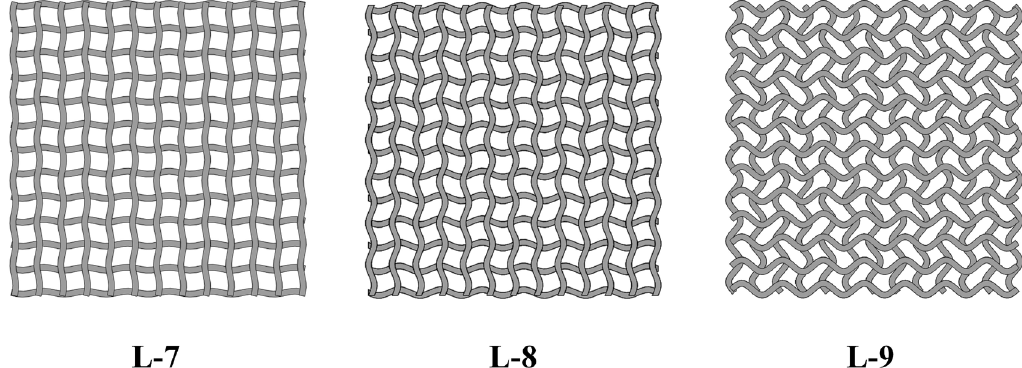
Figure 8. Plane diagrams of specimens with different